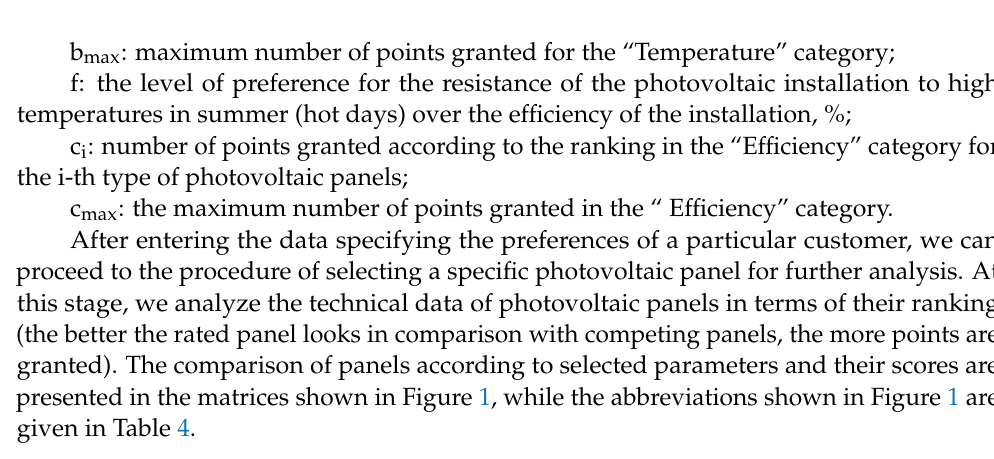
Table 4. Codification of types of photovoltaic (PV) panel manufacturing technologies.